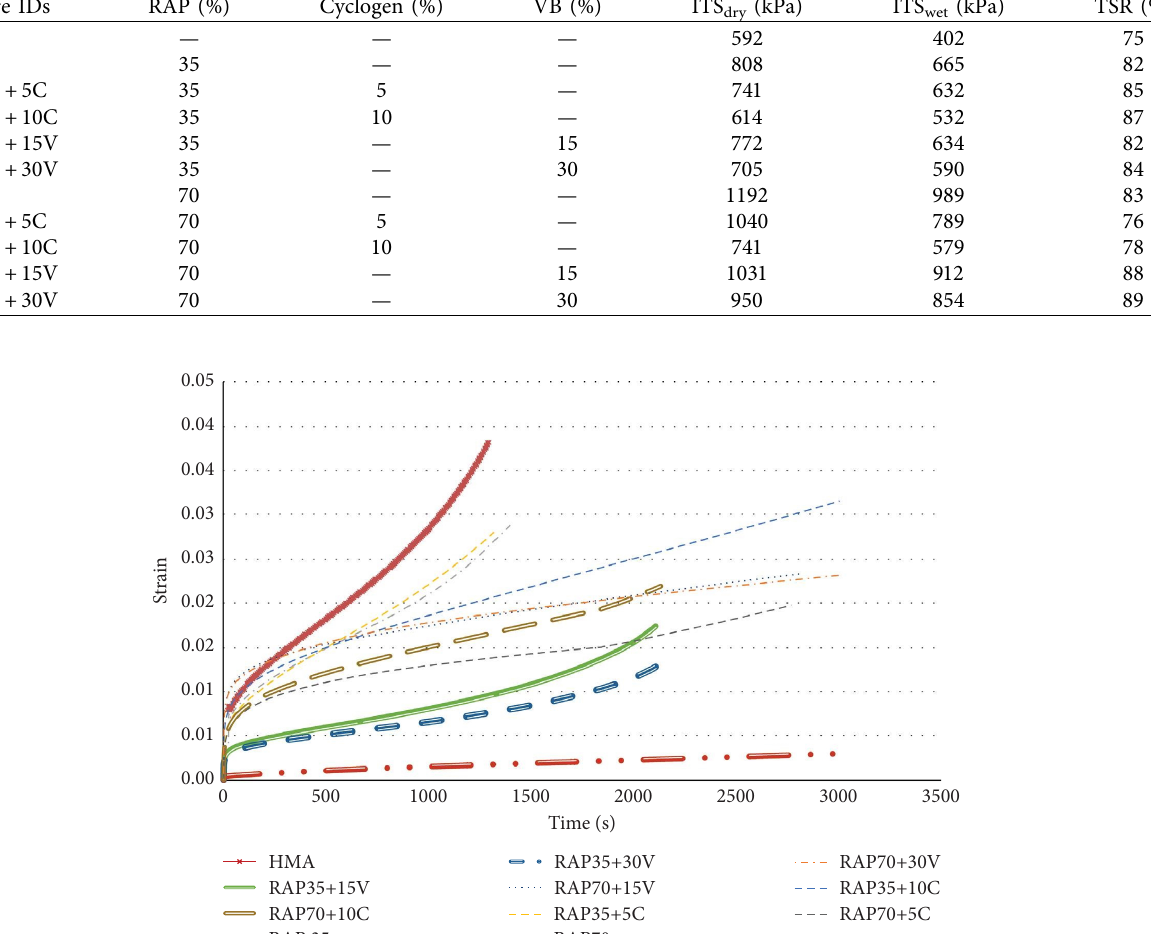
Table 3: Efect of Cyclogen and VB contents on the moisture resistance of HMA and RAP mixtures.